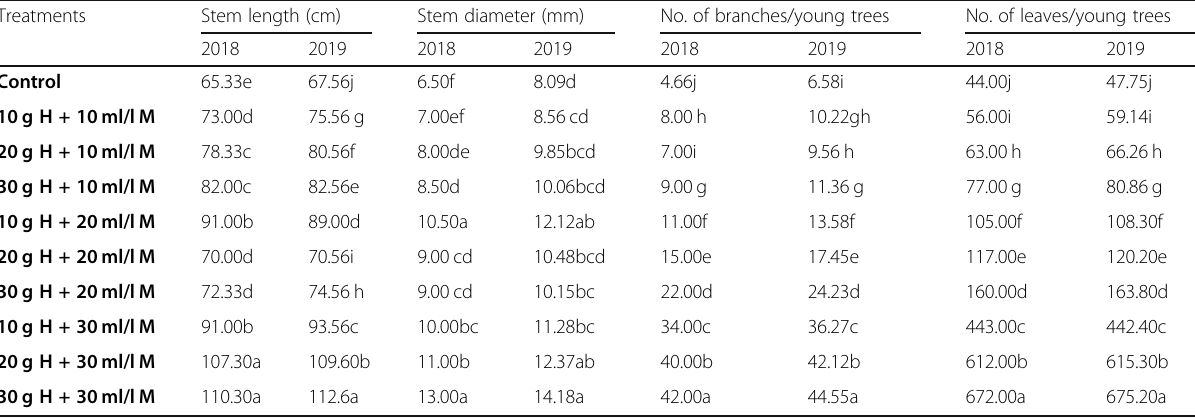
Table 2 Effect of soil application with humic acid and foliar spray of milagro on stem length, diameter, number of branches and leaves/young trees Treatments Stem length (cm) Stem diameter (mm) No. of branches/young trees No. of leaves/young